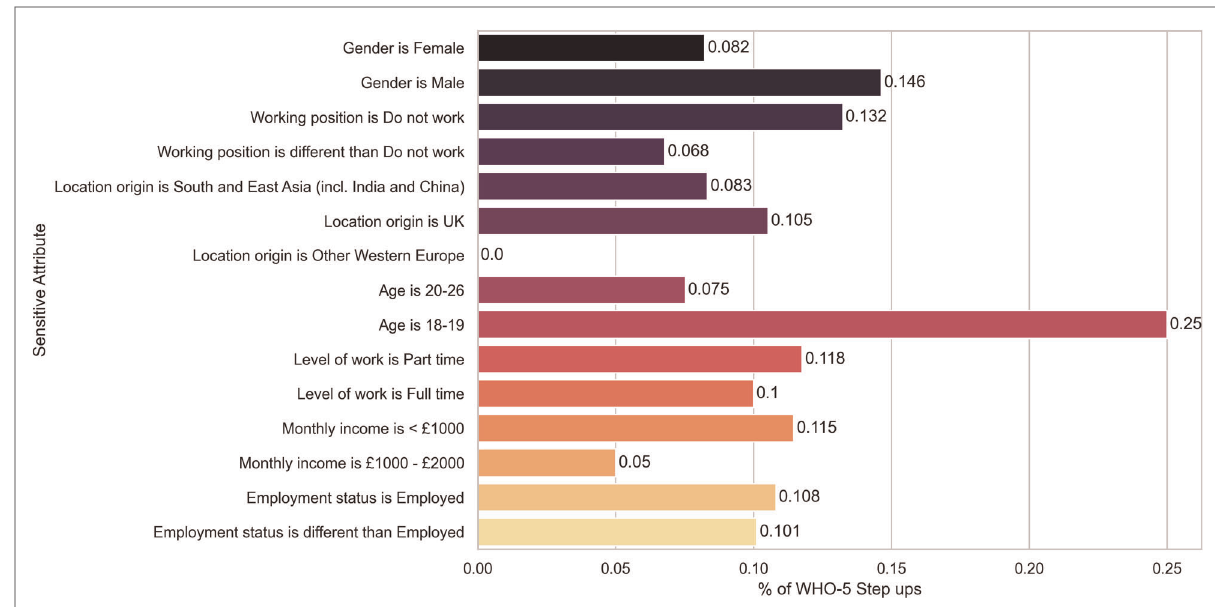
FIGURE 3 Today explore RecSys Clickthrough rate for each sensitive attribute. None of the differences remain statistically signi fi cant after correcting for multiple hypotheses